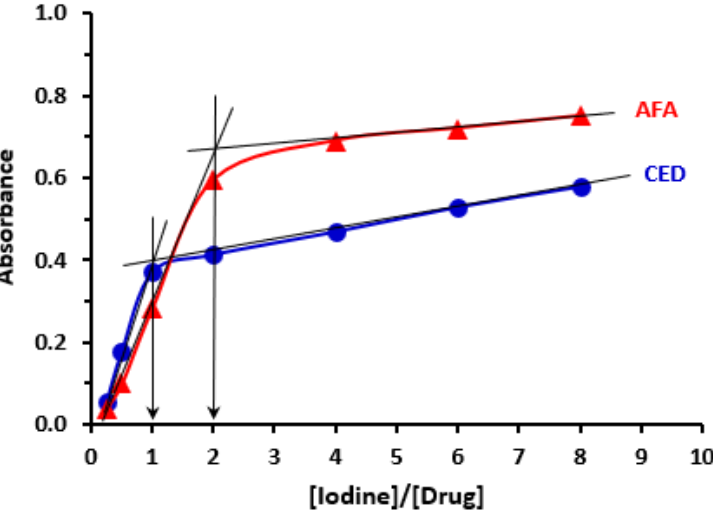
Figure 6. Plot of absorbance versus molar ratio of [Iodine]/[Drug] obtained from reaction mixtures containing a fixed concentration of drug and varying concentrations of iodine. The mole ratio cor- responds to the point of intersection of the tangents of the straight-line portions of the plots. Results are given for CER and AFA as representative examples for the molar ratios of 1:1 and 1:2, respec- tively.